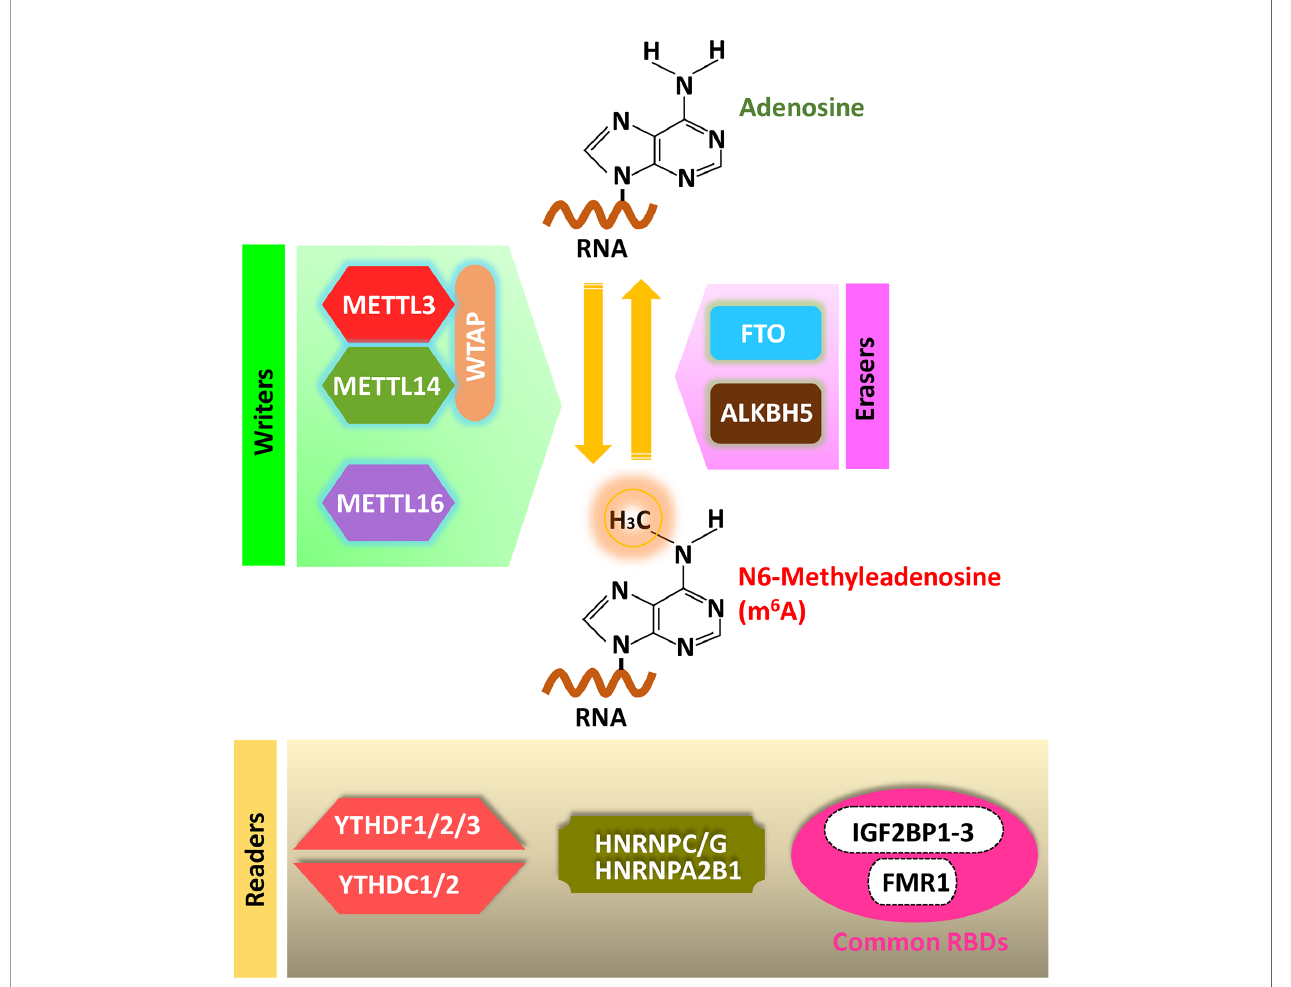
FIGURE 1 | Cellular m 6 A machinery: Writers, Erasers and Readers. Writer complex is composed of core subunits METTL3 and METTL14 with some additional adaptor proteins. METTL16 is also known as writer. Erasers: FTO and ALKBH5 are the known m 6 A erasers. Readers: YTH-domain containing proteins (YTHDF1-3, YTHDC1-2) directly recognize m 6 A- containing RNAs. A local structure disrupted by the presence of m 6 A could favor RNA-binding events of several heterogeneous nuclear ribonucleoproteins including HNRNPC/G and HNRNPA2B1. RNA binding proteins including IGF2BP1-3 and FMR1 prefer m 6 A-modi fi ed